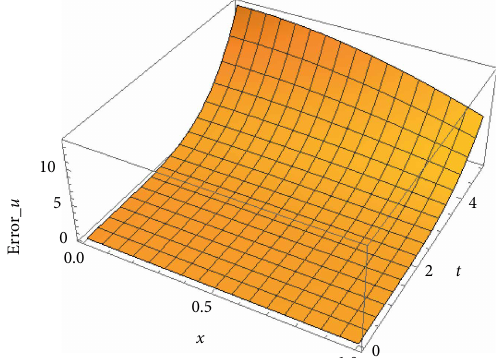
Figure 3: The figures explains the surface errors for Example